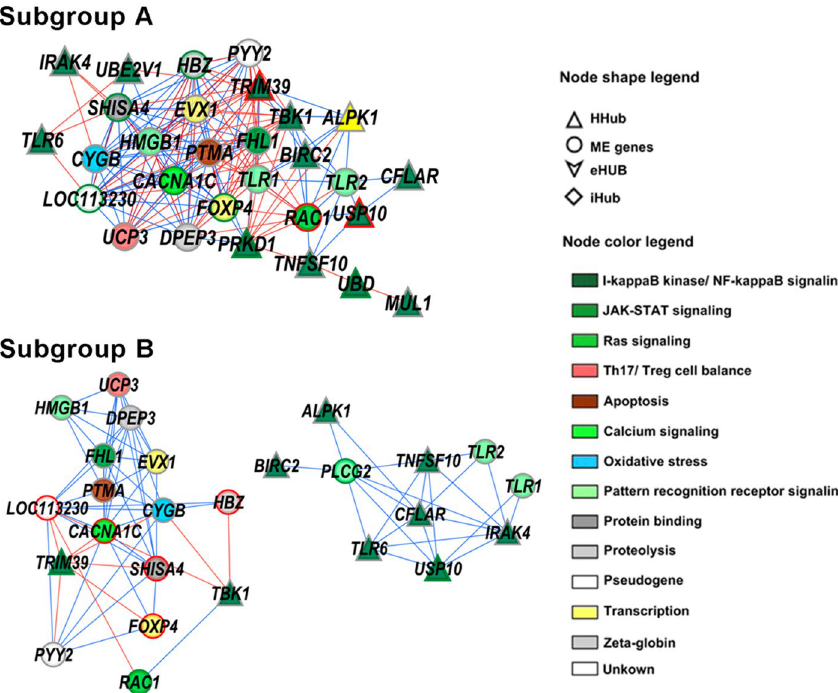
Figure 6. Subnetworks for the black module containing ME genes (non-HH module genes), hubs, and DEGs for the subgroups A and B. Red or blue links indicate positive or negative expression correlation values, respectively. Red or green border colors account for hyper-expressed or hypo-expressed genes,